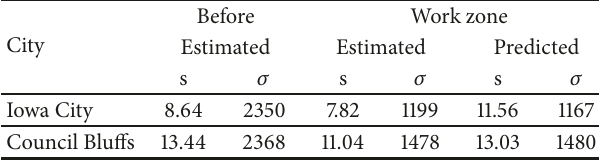
Table 5: Parametersof Fitted and Predicted Distribution